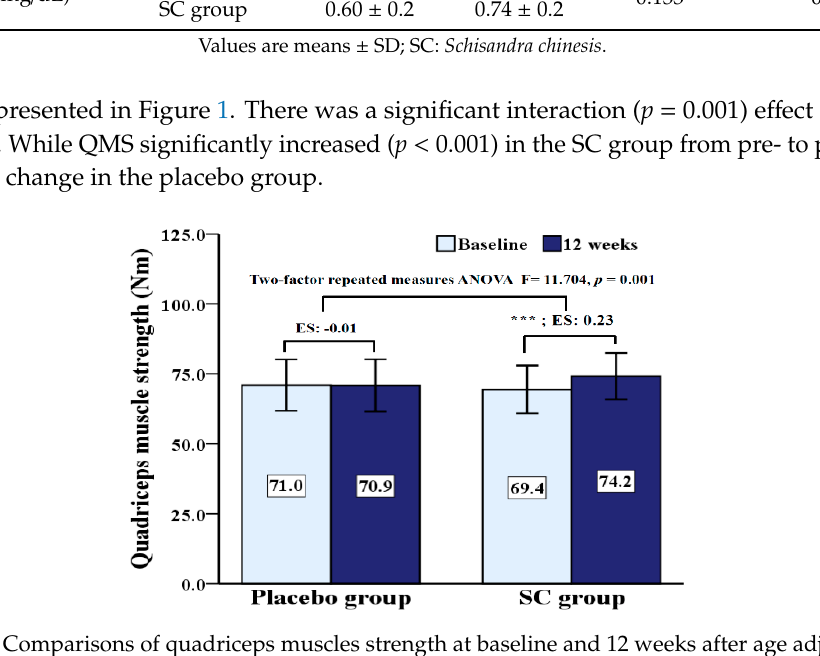
Figure 1. Comparisons of quadriceps muscles strength at baseline and 12 weeks after age adjustment.